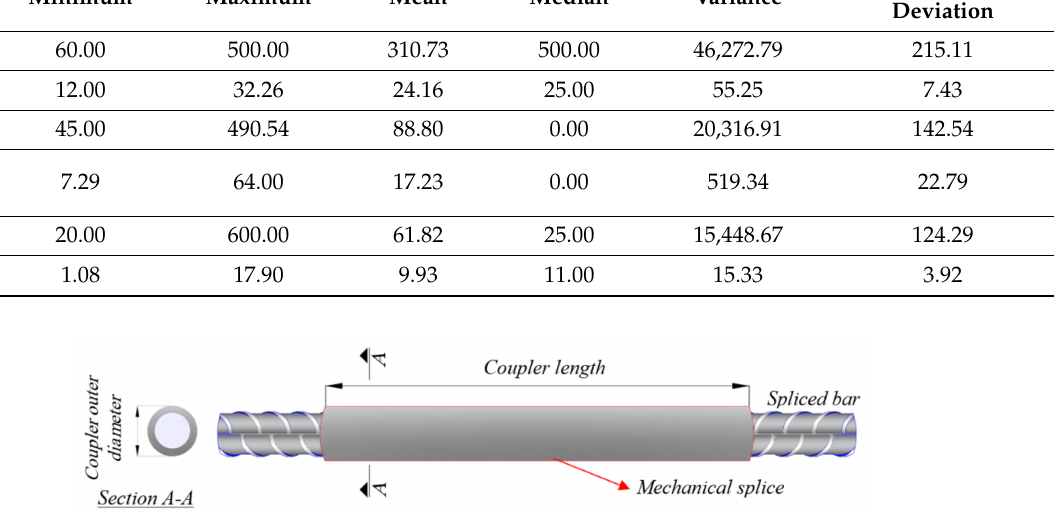
Figure 3. Schematic illustration of length and outer diameter of a mechanical